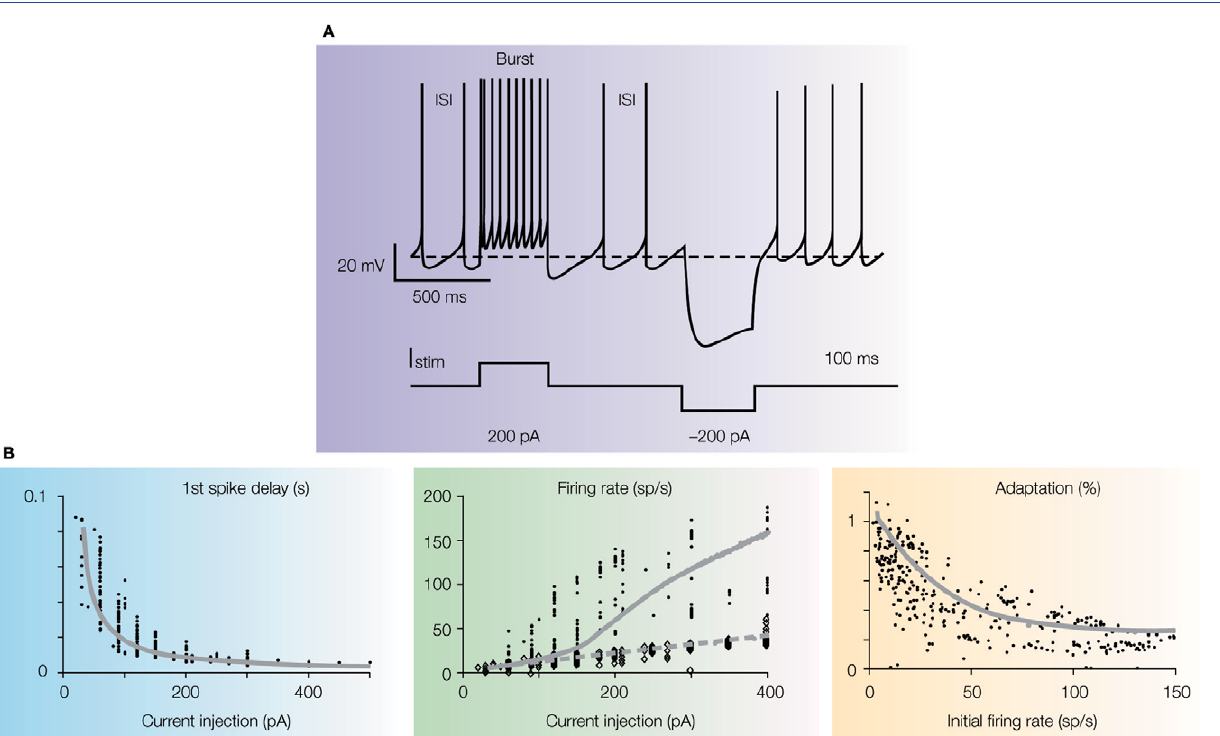
Figure 3 | Intrinsic electroresponsiveness I: response to current injection. (A) Numerical simulation of Golgi cell responses to current injection (the simulation closely reproduces the response recorded in patch-clamp recordings in acute cerebellar slices). Note that the cell is displaced from its pacemaker cycle by a depo- larizing pulse generating a burst with marked adaptation. At the end of the pulse the cycle is phase-reset and pacemaking restarts. A hyperpolarizing pulse causes sagging inward rectifi cation followed by a rebound excitation, during which the inter-spike interval (ISI) is shorter than the pacemaker cycle. (B) The graphs show the fi rst spike delay, fi ring rate and adaptation vs. injected current in Golgi cell patch-clamp recordings. In the mid panel, the fi ring rate is shown both for the fi rst ISI (small dots) and after adaptation has occurred (large dots). The data are interpolated by the model (gray lines; two separate fi ttings are reported for the two data sets in the mid-panel). Adapted from Solinas et al.